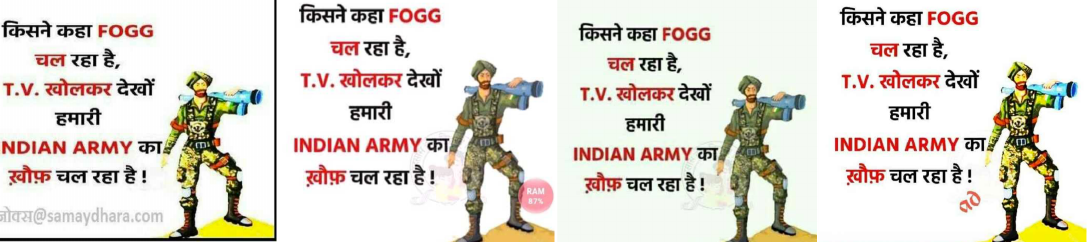
Figure 3. Four examples of the same image with different characteristics, clustered together using Facebook PDQ hashing: (a)image with a border added, (b) image with a red watermark, (c) image with a different background, and, (d) image with a different color filter applied and a red logo